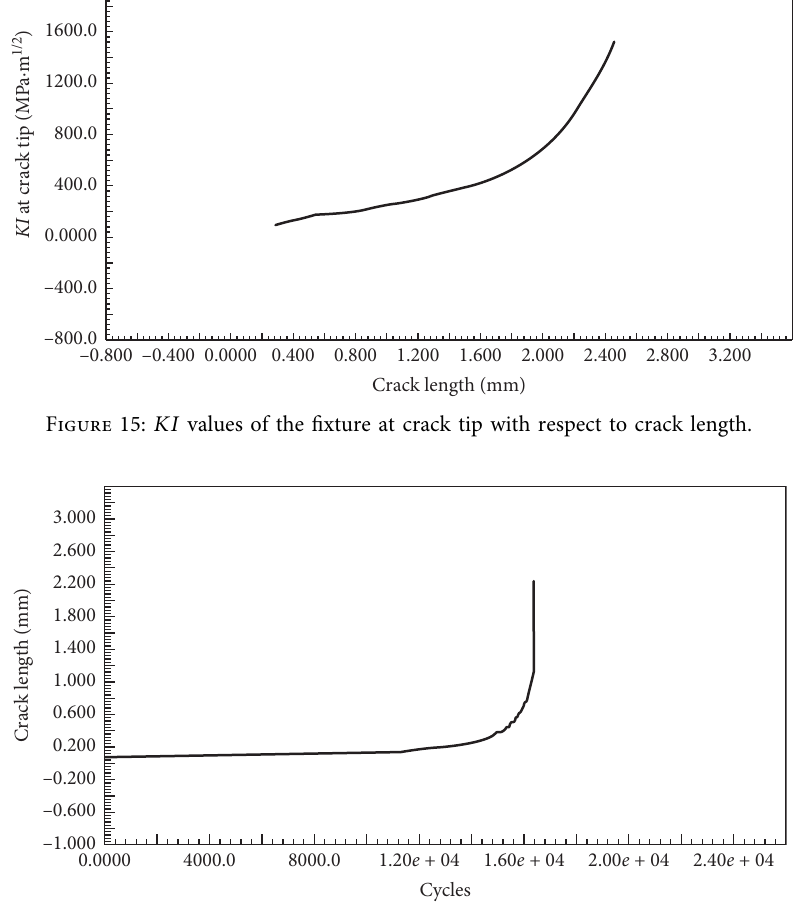
Figure 16: Relationships between cycle number and crack